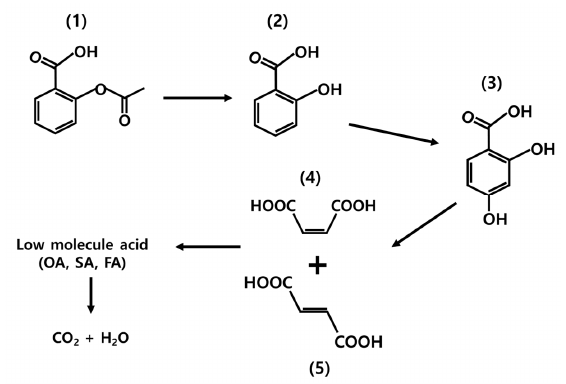
Figure 6. The proposed degradation mechanism of ASA by PiLP.